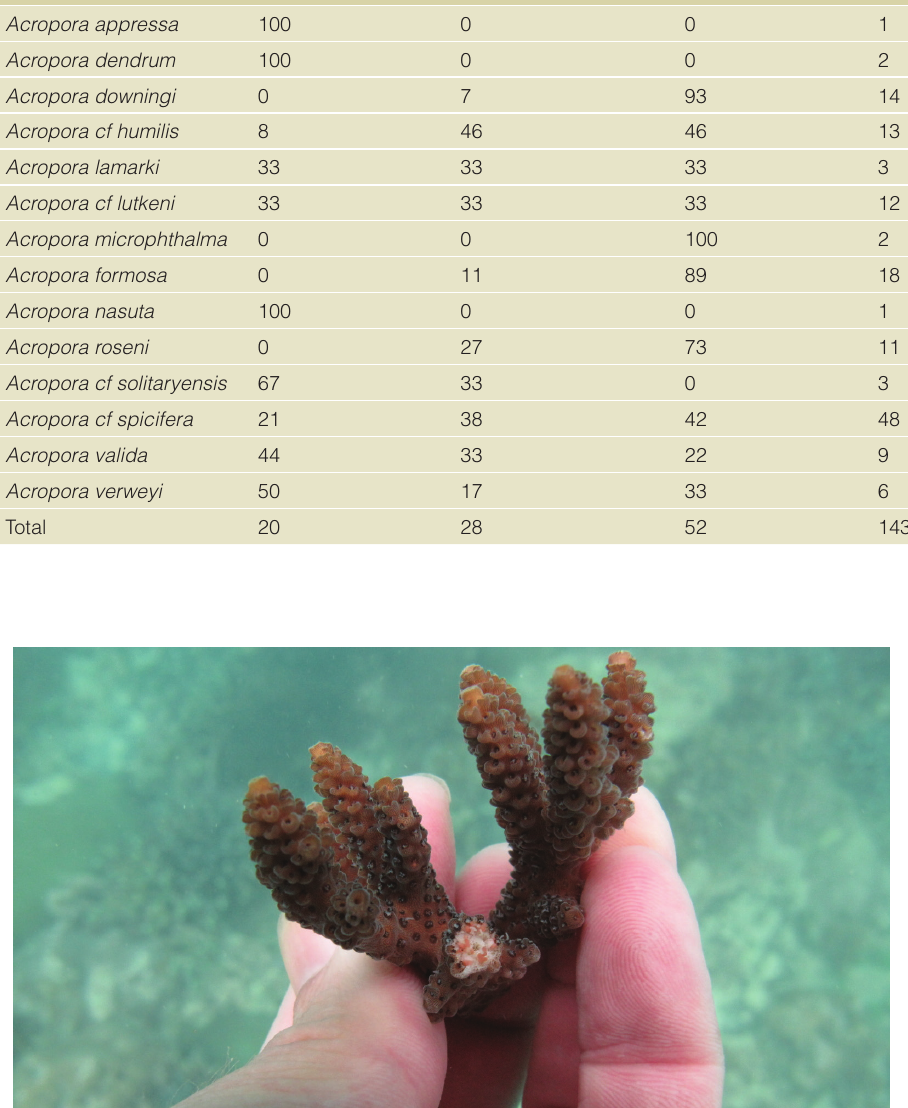
Table 1. The percentage of Acropora colonies with mature-, immature- or no oocytes, sampled between 31 January and 8 February 2014 on Socotra Yemen. n = number of sampled colonies. Species